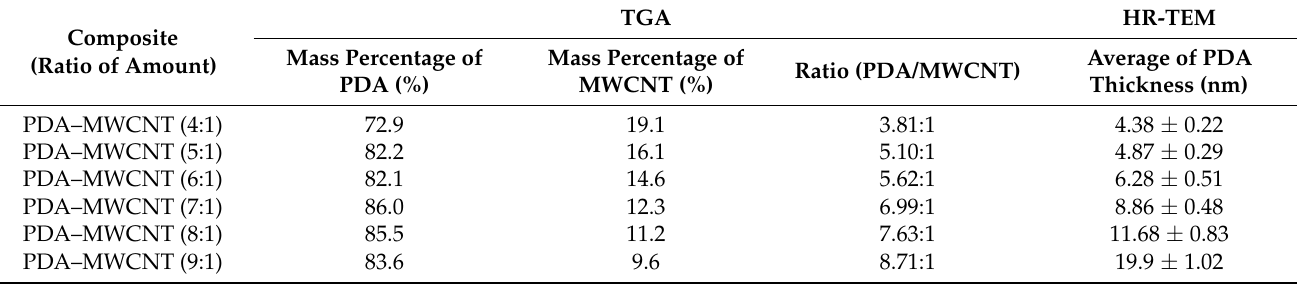
Figure 2. HR-TEM images of various ratio between PDA and MWCNT with ( a ) 4:1, ( b ) 5:1, ( c ) 6:1, ( d ) 7:1, ( e ) 8:1, and ( f ) 9:1. Table 1. Summary of the ratio between PDA and MWCNT by TGA and